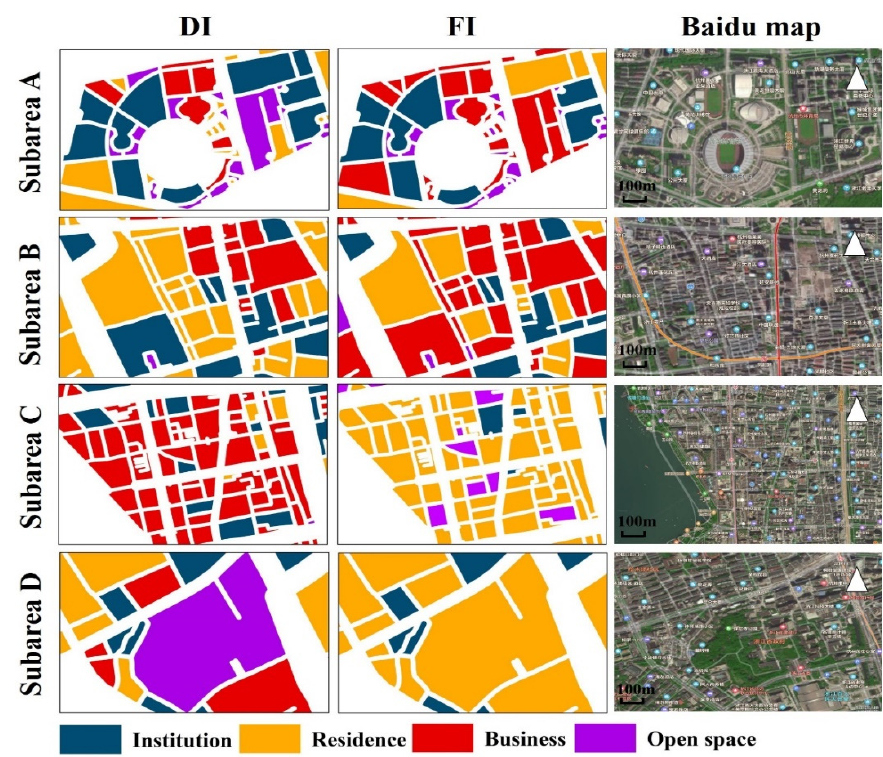
Figure 8. Classification results of DI and FI methods and testing samples in the test regions. Subareas A, B, C, and D were selected randomly in Hangzhou city, and each region was shown with DI-based classification, FI-based classification, and Baidu map. The Chinese labels for the subfigure of right column represent the name of POIs.